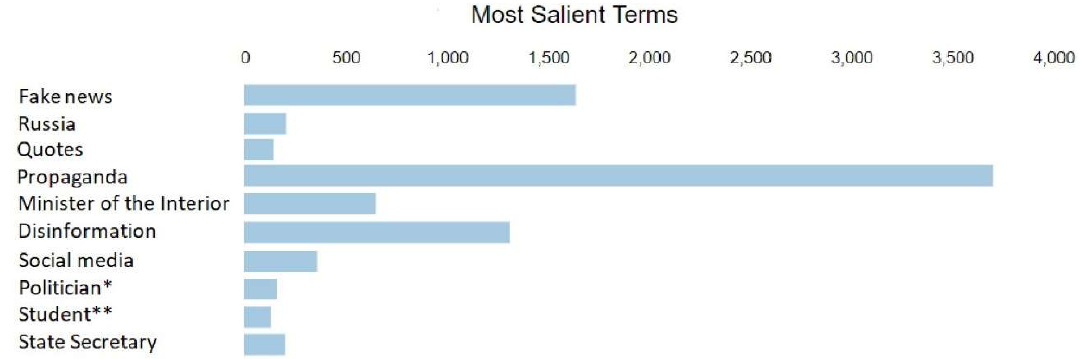
Figure 2. Topic model of Top-10 most salient terms in tweets. * Anonymized Twitter account of a politician, ** anonymized Twitter account of a student.